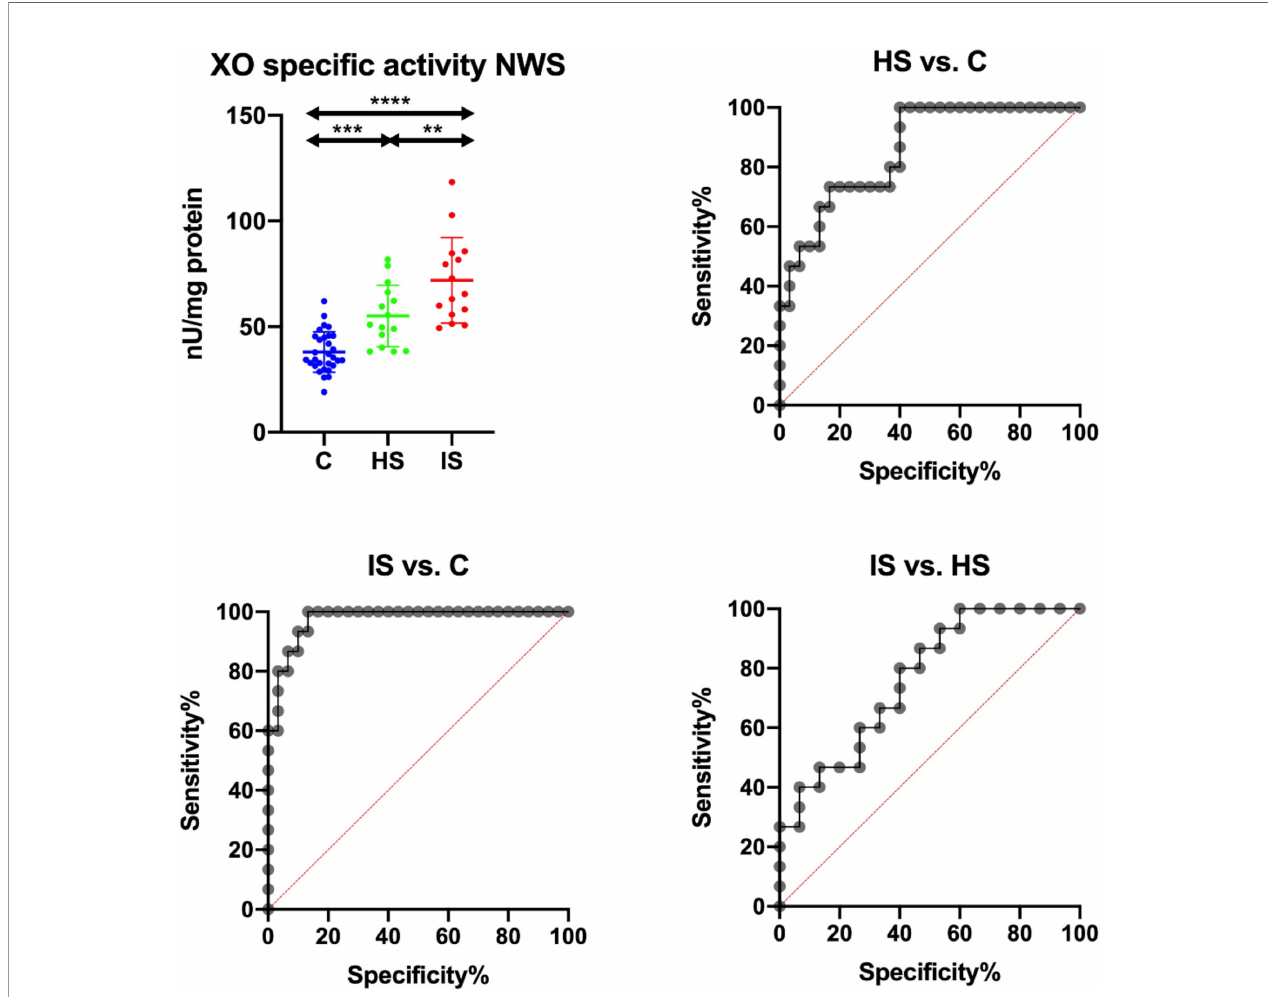
FIGURE 3 | Results of ROC analysis for salivary XO speci fi c activity in NWS. C, Control group ( n = 30); HS, hemorrhagic stroke group ( n = 15); IS, ischemic stroke group ( n = 15); NWS, non-stimulated whole saliva; XO, xanthine oxidase. Differences statistically signi fi cant at: **p < 0.005; ***p < 0.0005; ****p <